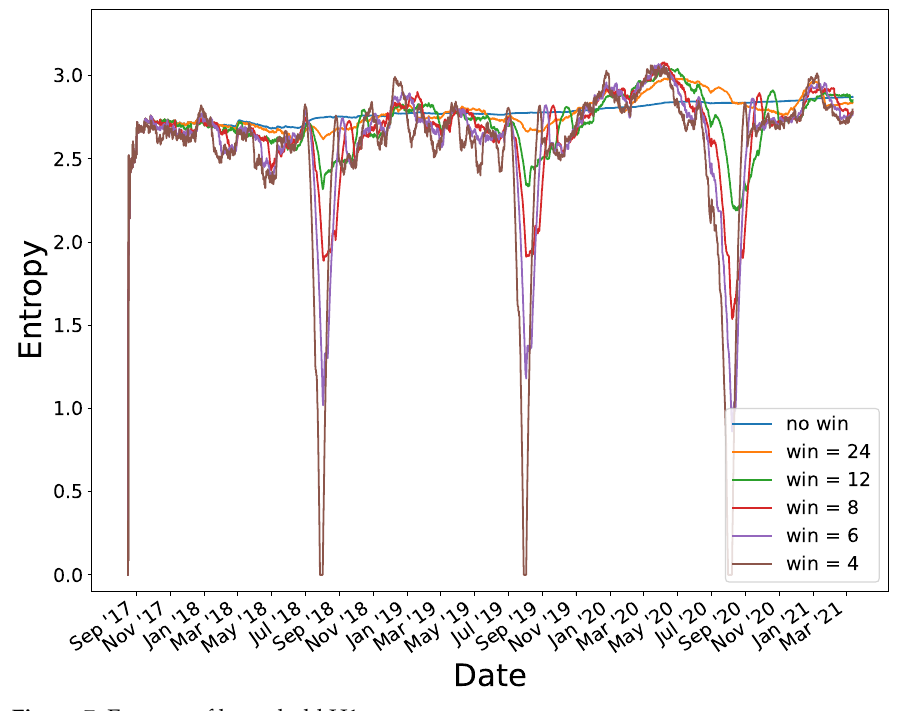
Figure 7. Entropy of household